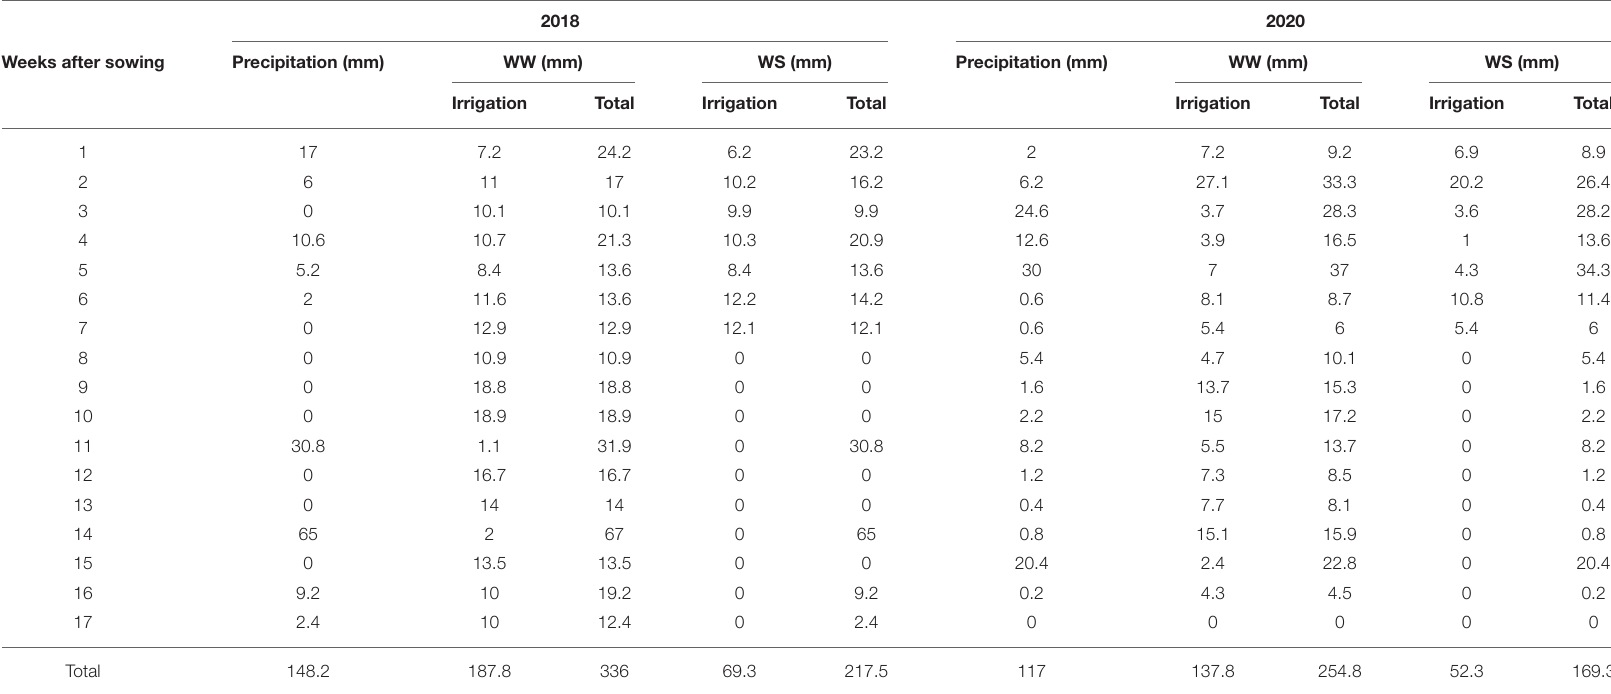
TABLE 2 | Precipitation and irrigation (mm) applied in experiments under well-watered (WW) and water-stressed (WS) conditions in the crop seasons of 2018 and